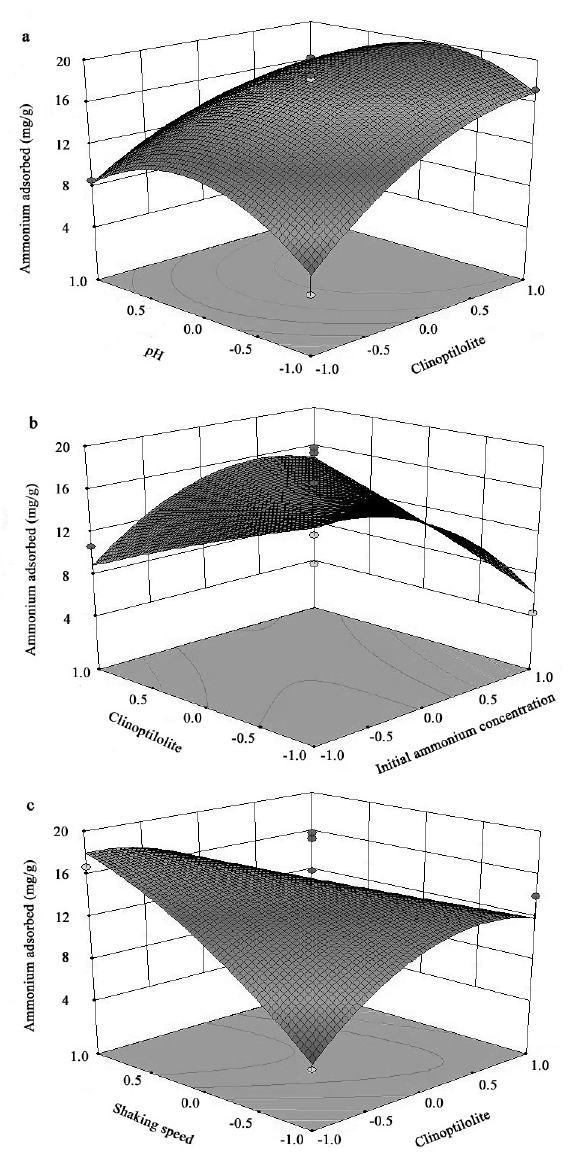
Figure 1: Significant interaction terms for ammonium removal by clinoptilolite: (a) pH-Clinoptilolite, (b) Clinoptilolite-Initial ammonium concentration, (c) Shaking